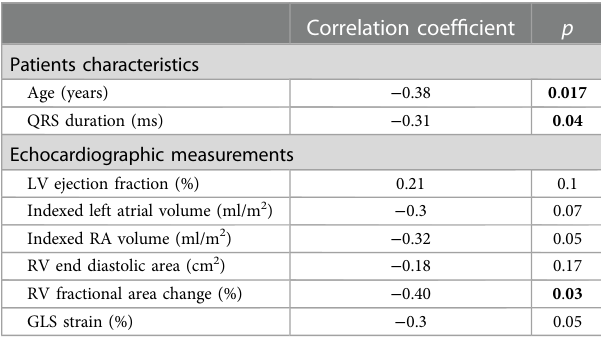
TABLE 4 Correlations with LA compliance a